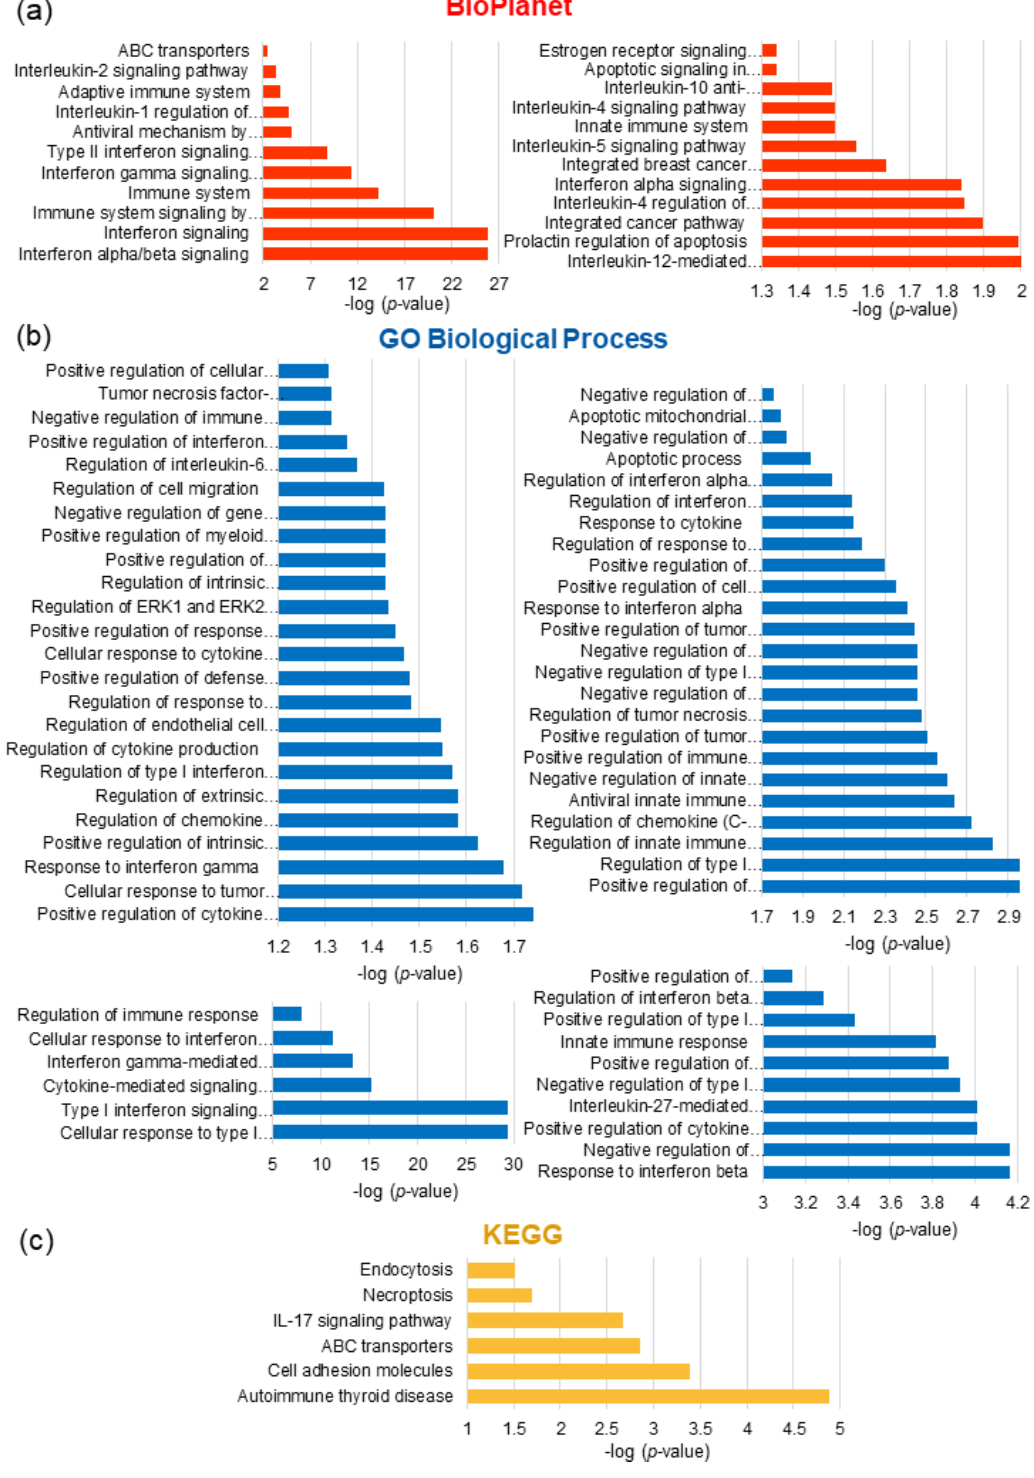
Figure 8. Bar graph showing pathway enrichment analysis of DRGs in spheroids transfected with miR193a and the mimic control. Gene enrichment analysis by ( a ) BioPlanet (red), ( b ) GO Biological Process (blue), and ( c ) the KEGG (yellow; the Kyoto Encyclopedia of Genes and Genomes). p <